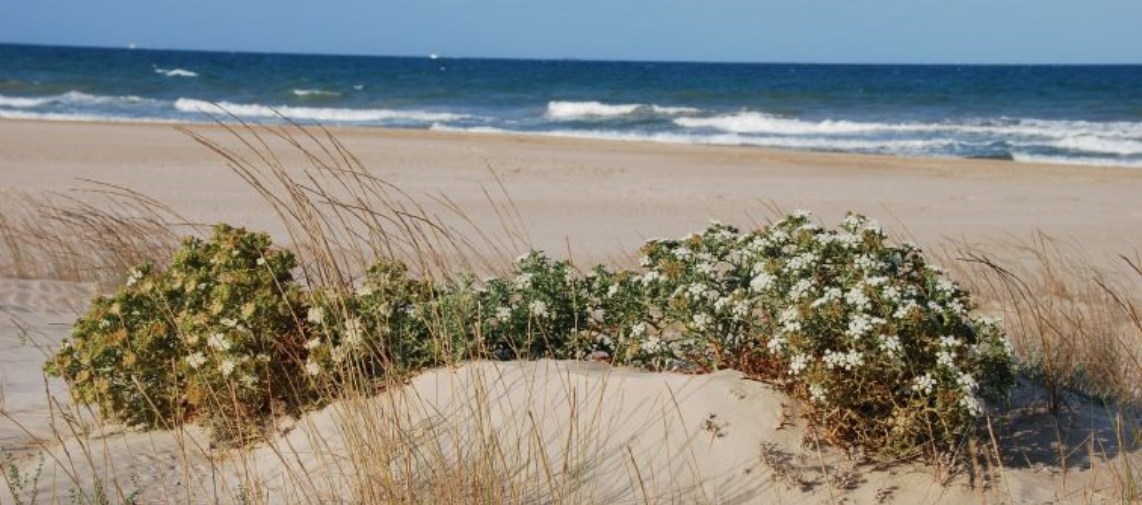
Figure 2. Albufera Natural Park. Source: www.valenciaturisme.org. (accessed on 21 October 2021)